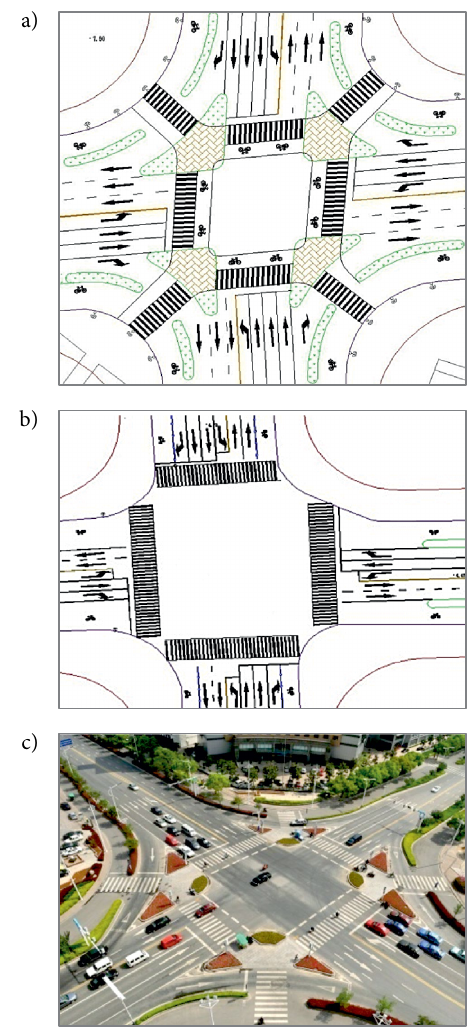
Fig. 9. The before and after of optimization of X